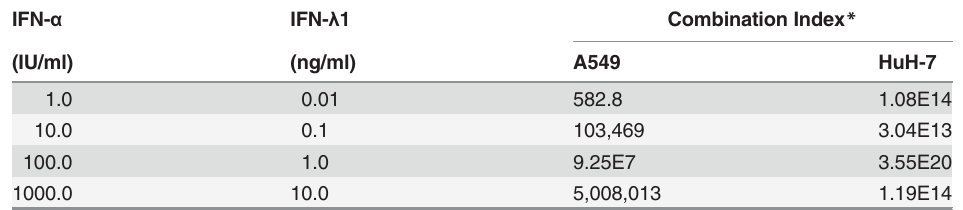
Table 1. Combination index for IFN- α and IFN- λ 1 against CCHF replication respectively in A549 and HuH-7 cells. IFN- α IFN- λ 1 Combination Index *